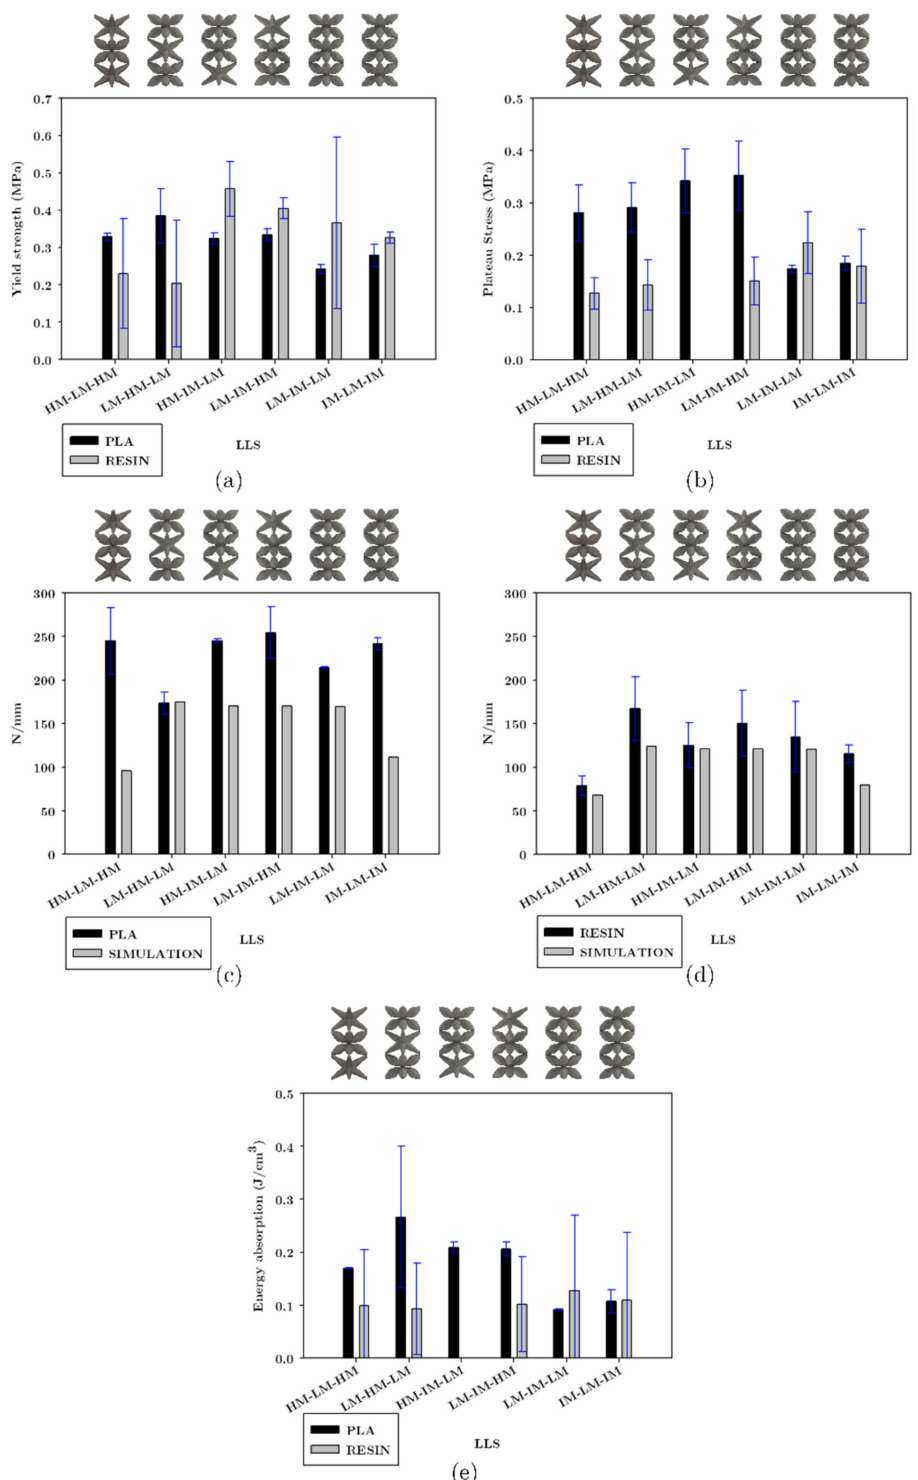
Figure 23. Comparative mechanical properties graph between lattices structures LLS manufactured: ( a ) yield strength, ( b ) plateau stress, ( c ) stiffness comparative between experimental FFF and FEA, ( d ) stiffness comparative between experimental LCD and FEA, and ( e ) energy absorption of PLA and resin lattice structures. Representative distribution of layers is included on top of each bar graph for the reader’s